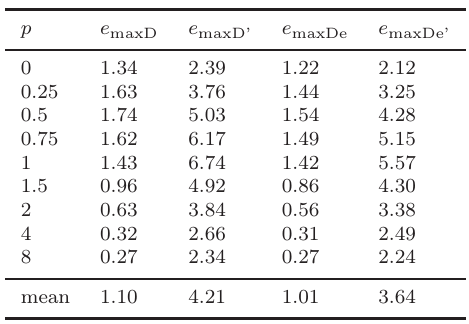
Table 6. Means of error ratios for v